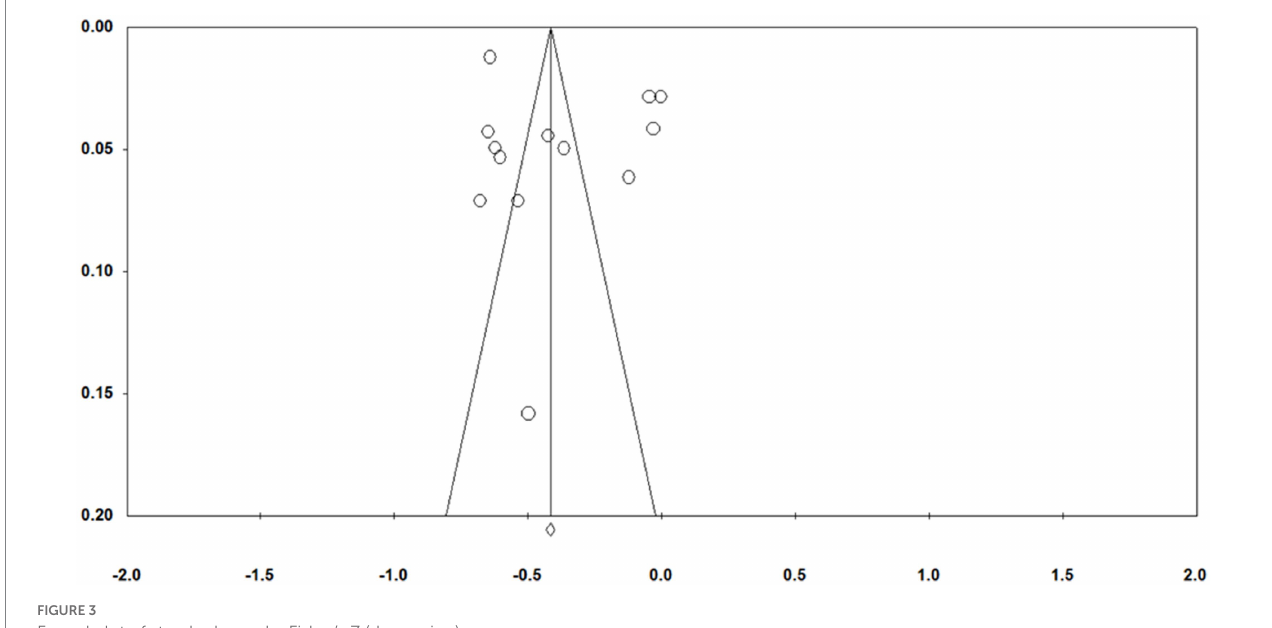
FIGURE 3 Funnel plot of standard error by Fisher’s Z (depression).